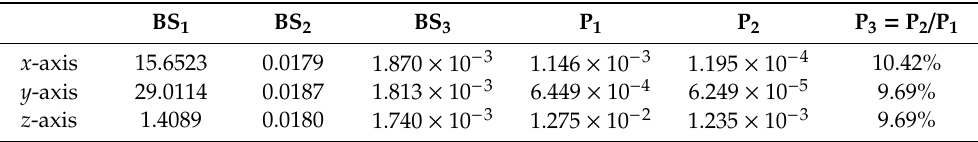
Table 6. Bias stabilities of the experimental data in 4th experiment.